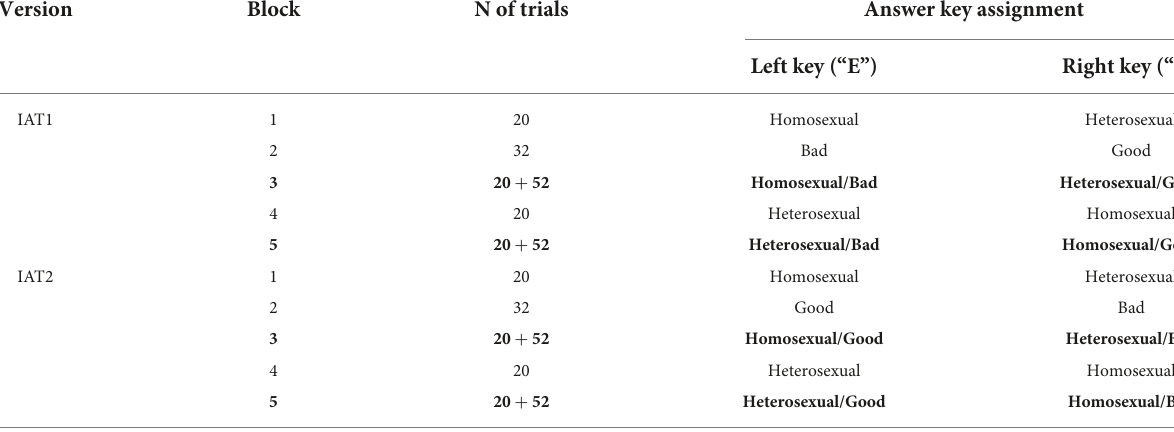
TABLE 2 Protocol of the IAT versions and answer keys assignment.